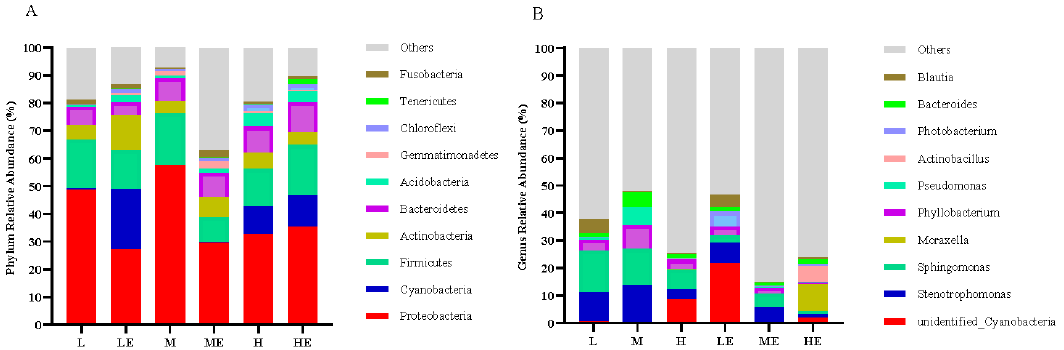
Figure 4. Intestinal microbial composition in grouper (Figure 4A = Phylum relative abundance; Figure 4B = Genus relative abundance).